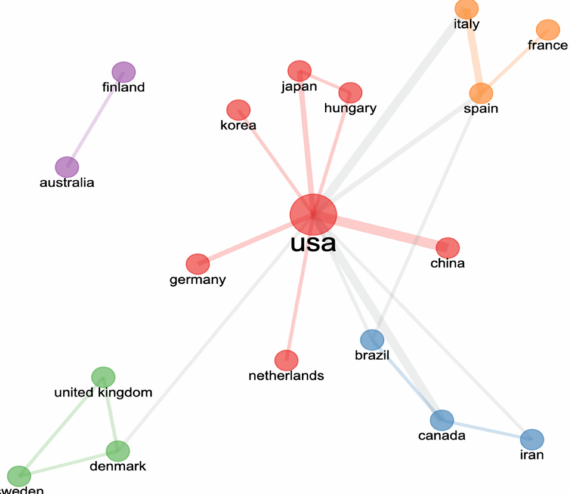
Figure 7. Cooperation between contributing countries on AD exercise research.